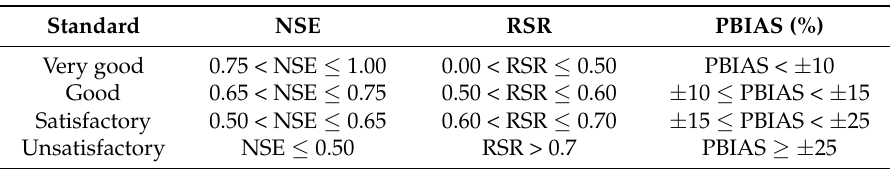
Table 3. Monthly runoff evaluation standard.